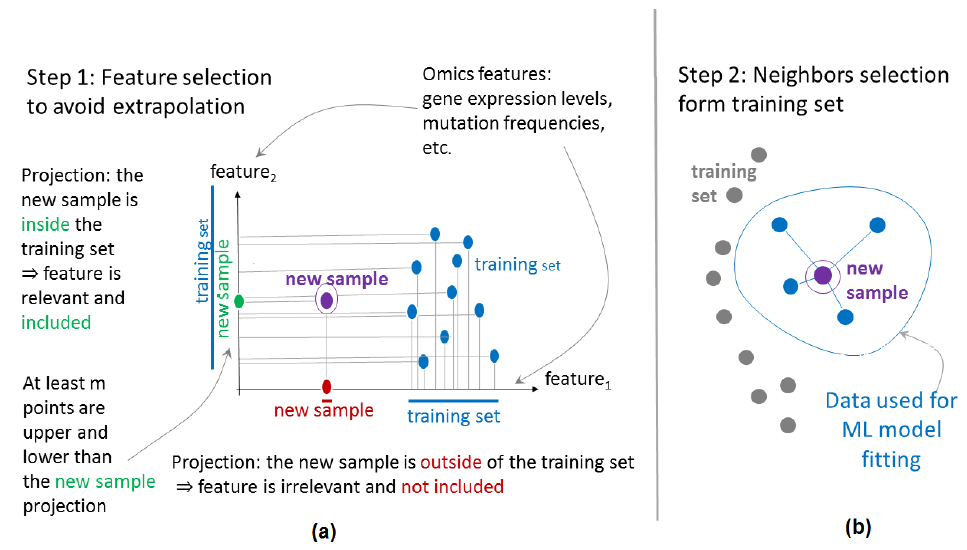
Figure 3. Outline of floating window projective separator (FloWPS) approach. Selection of relevant features ( a ) and nearest neighbors ( b ) are schematized.